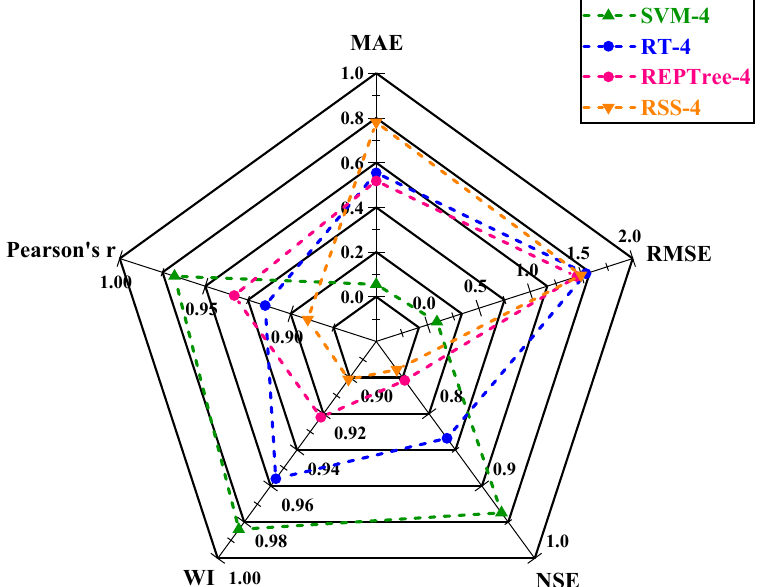
Figure 10. Radar charts display the best performance indicators of SVM-4, RT-4, REPTree-4, and RSS-4 models during testing at the New Delhi station.